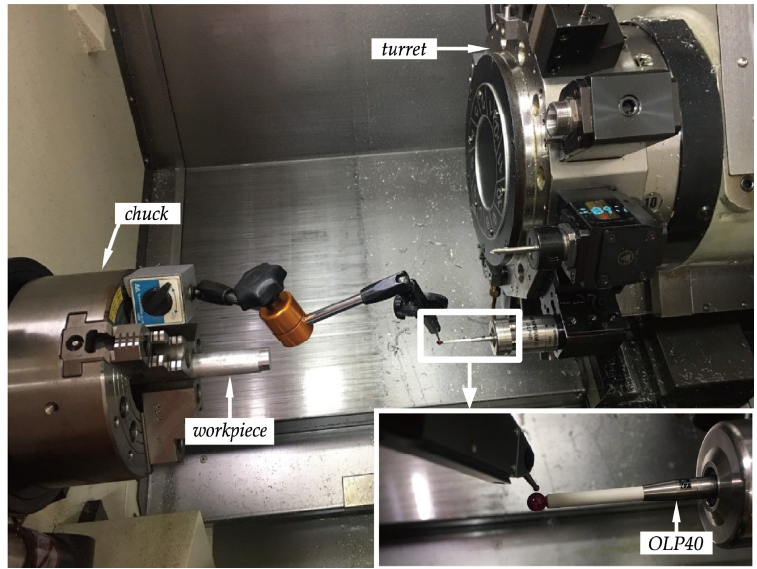
Figure 7. Calibration of the probe offset with a lever-type dial